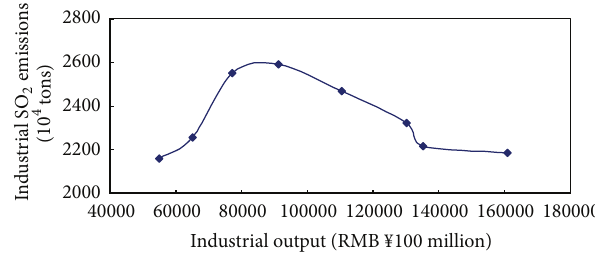
Figure 1: China’s industrial SO 2 emissions correlated with gross industrial output values. Table2:Thevaluesofparameters 𝑛 , 𝑟 , 𝑟𝑓 ,and 𝑟𝑝 in(7),theestimates ofmodelparameters 𝑏 1 , 𝑏 2 ,and 𝑢 in(10),andthevaluesofRMSPEPR and RMSPEPO in (38) and (39).